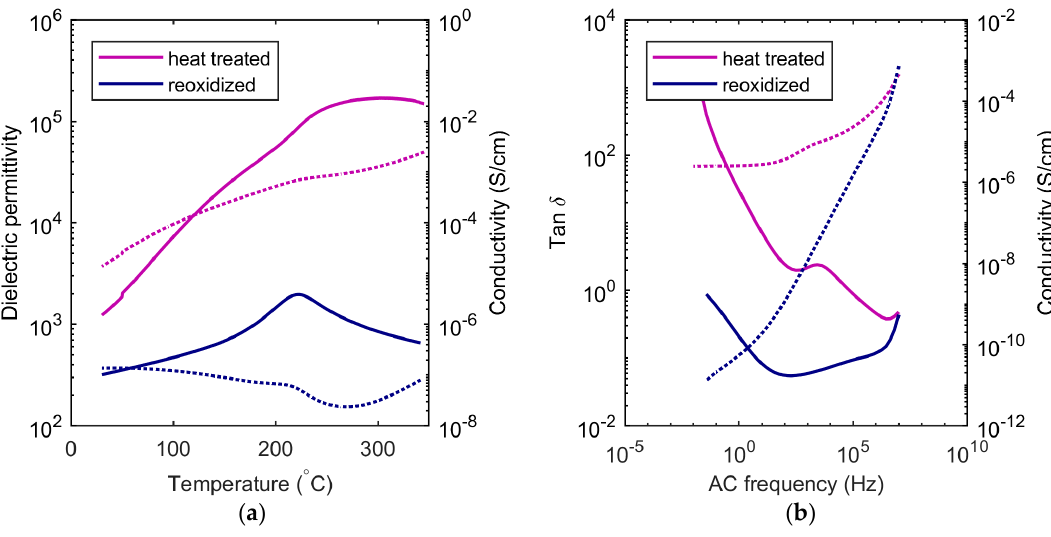
Figure 6. ( a ) Permittivity (solid lines) and AC conductivity (dotted lines) at 1000 Hz as a function of temperature for the SBN33 sample heat treated at 1350 °C before and after reoxidation. ( b ) tan δ (solid lines) and AC conductivity (dotted lines) for the same two samples as a function of frequency.